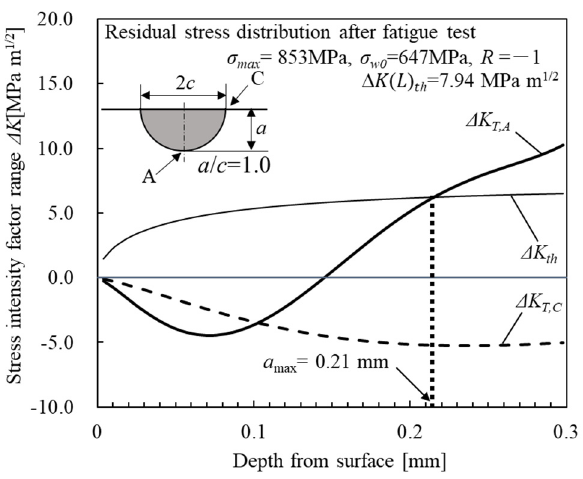
Figure 11. Relationship between stress intensity factor range and depth from the surface